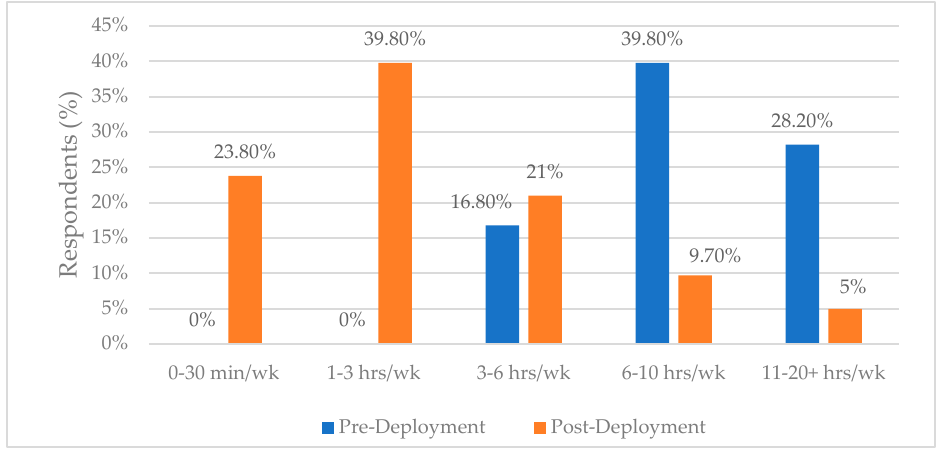
Figure 1. Physical Training Conducted.